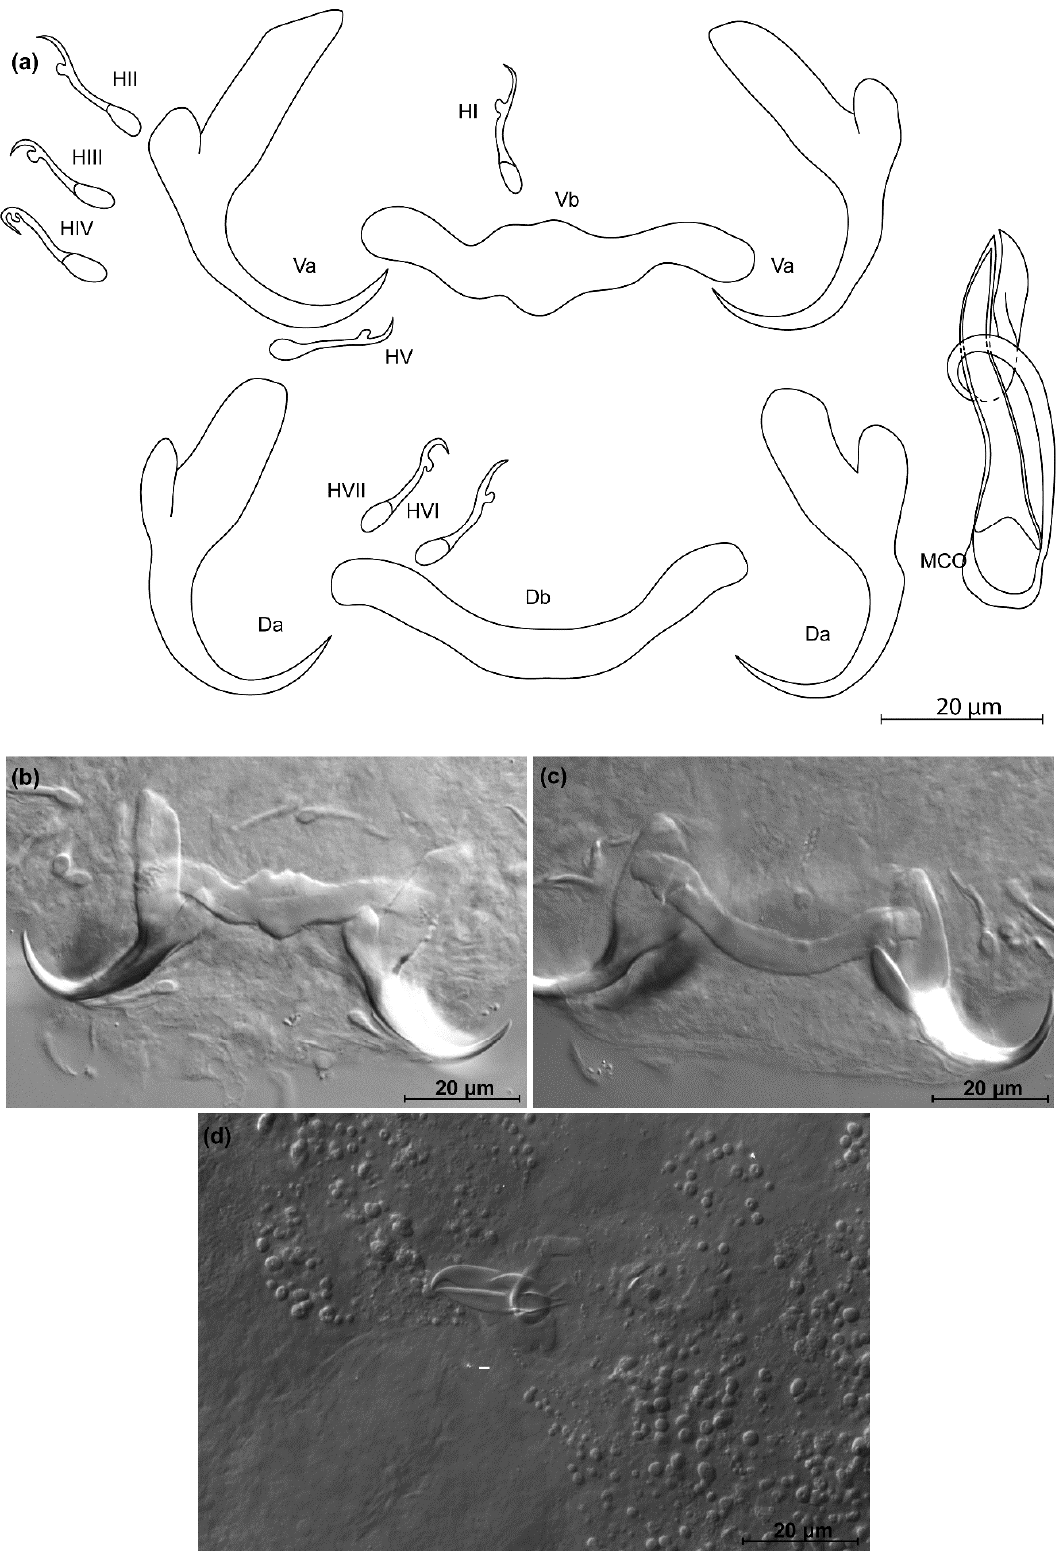
Figure 7. Kapentagyrus marispastoris n. sp. (ex Odaxothrissa mento ). ( a ) Drawings of sclerotized structures, Va-ventral anchors, Da-dorsal anchors, Db-dorsal bar, Vb-ventral bar, H-hooks (pairs I to V—ventral; pairs VI, VII—dorsal), MCO-male copulatory organ. ( b ) Micrograph of ventral anchors and ventral bar. ( c ) Micrograph of dorsal anchors and dorsal bar. ( d ) Micrograph of MCO.